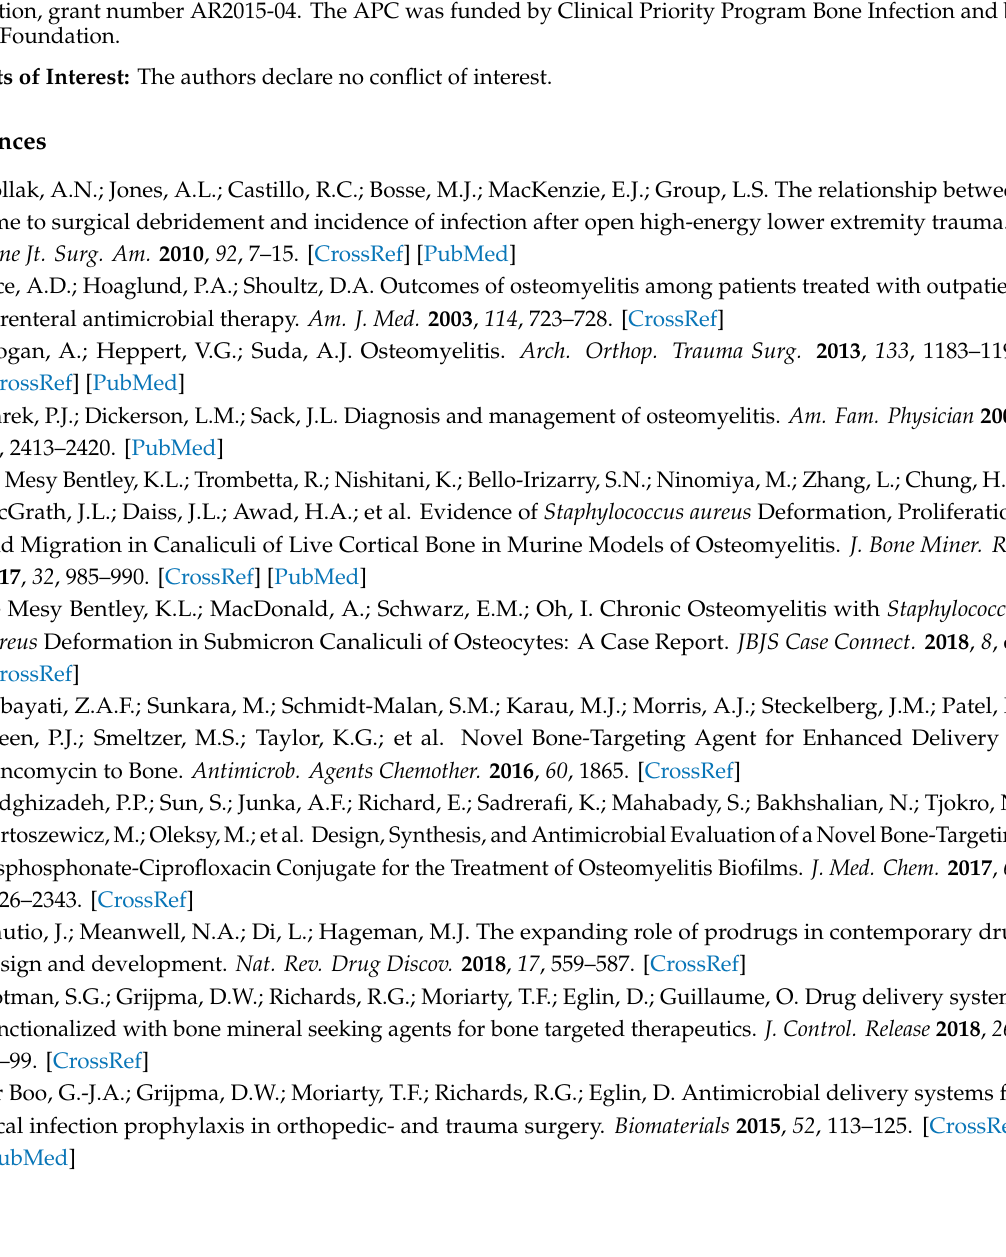
Figure S1: OD 600 measurements of bacterial suspensions and antibiotic loaded PCL / cPVA-ASP microsphere dispersions over 48